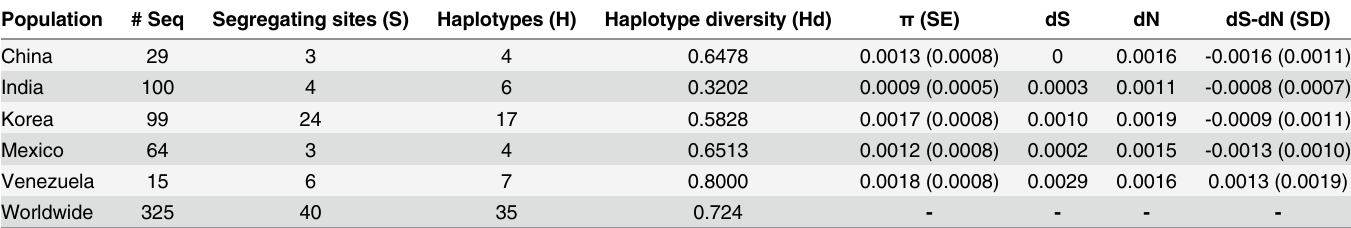
Table 4. Pvs25 gene worldwide polymorphism by